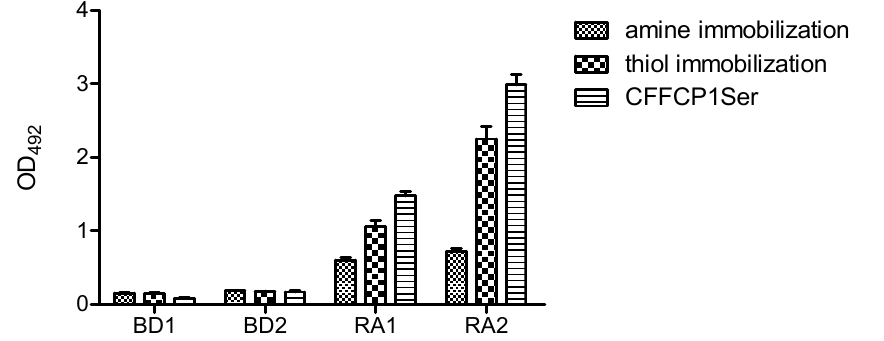
Figure 9. Reactivity of rheumatoid arthritis (RA) and blood donor (BD) sera with duplex OPC. For amine immobilization OPC-8 with its complementary strand 5 ′ AAGAGAAAAGAATTTTT-NH 3 ′ was used while for thiol immobilization OPC-8 2 with 5 ′ AAGAGAAAAGAATTTTT-SH 3 ′ was used. The peptide CFFCP1Ser was added as positive control. A concentration of 250 pmol/well of duplex OPC-8 was immobilized on the corresponding ELISA